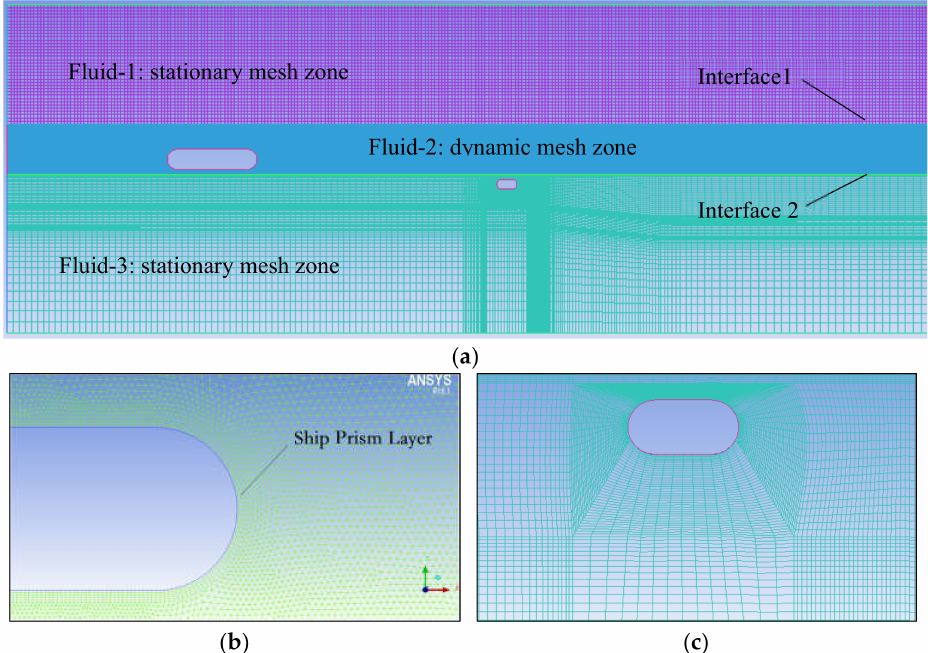
Figure 16. Schematic of 2D numerical model meshing for ship–bridge intersection: ( a ) Schematic of a subregional grid; ( b ) Grid near the wall of a ship; ( c ) Grid near the wall of a round-ended